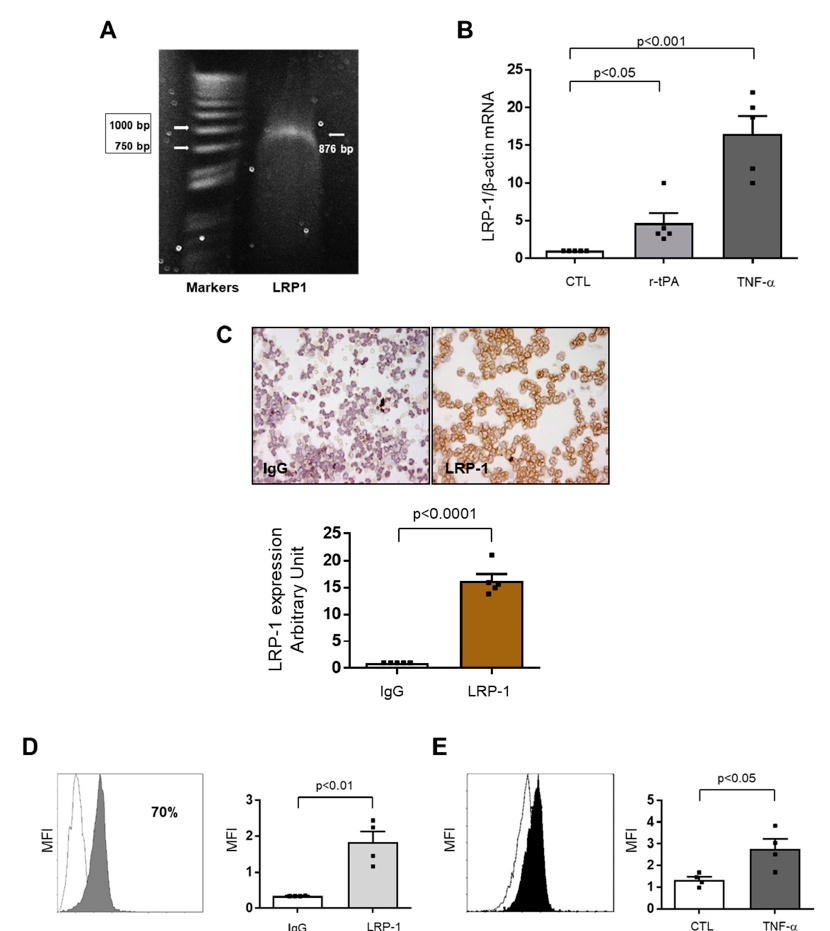
Figure 2. Low density lipoprotein receptor-related protein 1 (LRP1) is expressed on human neutrophil membrane. ( A ) Representative agarose gel of PCR products from human neutrophils showing an 876 amplicon. On the left, the molecular weights of the markers are shown. ( B ) Recombinant tissue plasminogen activator (r-tPA) and tumor necrosis factor (TNF)- α increase LRP-1 mRNA expression as assessed by real-time RT-PCR: cells were stimulated in presence or absence of 0.1 mg / mL r-tPA or 200 U / mL of TNF- α . All data were first normalized to β -actin mRNA and values were expressed as fold increase ± 1 SEM vs. untreated (CTL) cells, n = 5. ( C ) Immunocytochemistry of human neutrophil. Representative images of LRP-1 staining and densitometric analysis of digital images. Data are expressed as mean ± 1 SD, n = 5. ( D ) Flow cytometry analysis of human neutrophils. Grey profile: LRP-1 expression of human neutrophils freshly purified from peripheral blood and labelled with anti-LRP-1; white profile: neutrophils freshly purified from peripheral blood and labelled with an isotype-matched negative control antibody. Results were expressed as median fluorescence intensity, n = 4. ( E ) TNF- α increases LRP-1 expression. Flow cytometry analysis: human neutrophils stimulated with medium alone (CTL, white profile) or 200 U / mL of TNF- α (black profile) and labelled with the anti-LRP-1 antibody. Results were expressed as median fluorescence intensity (MFI: ± 1 SEM), n =